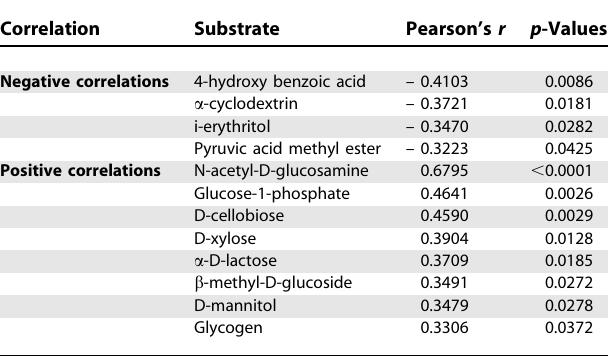
Table 2. Correlations between WCD Values of BIOLOG Carbon Sources and the Concentration of the Cry1Ab Protein as Measured at the Beginning of the Experiment